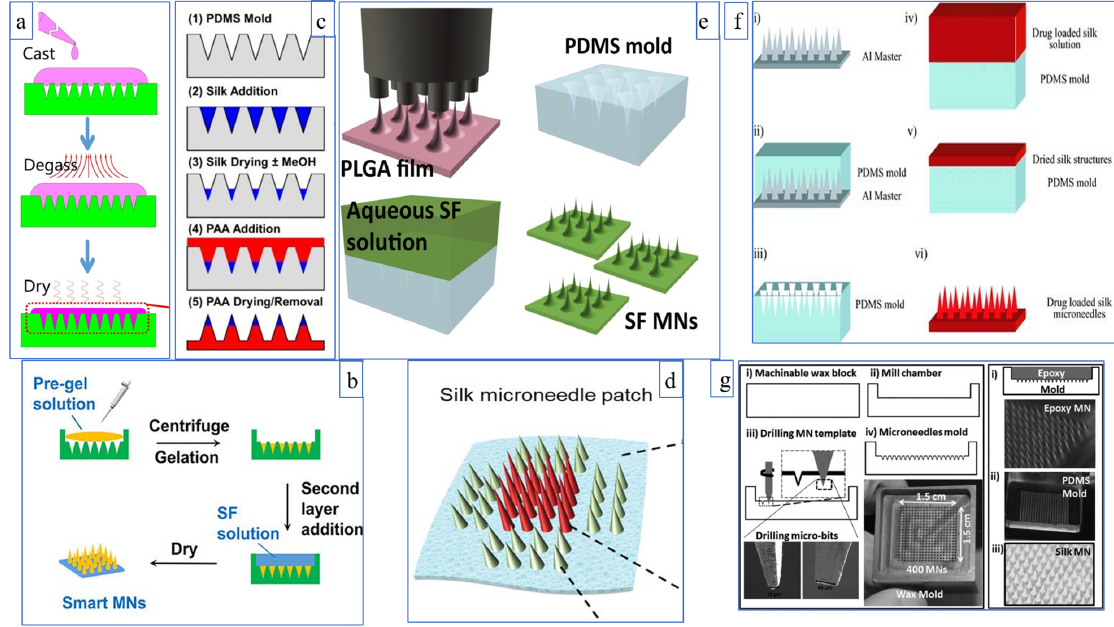
Figure 6. ( a ) The tip and the base are the same solution; ( b , c ) Different solution between tip and base; ( d ) Different microneedles in different positions; ( e ) Negative mold for hot ‐ drawn material; ( f ) Aluminum needle master plates prepared by high ‐ speed micro ‐ milling; ( g ) Wax plate drilling for template preparation. Image used with permission of